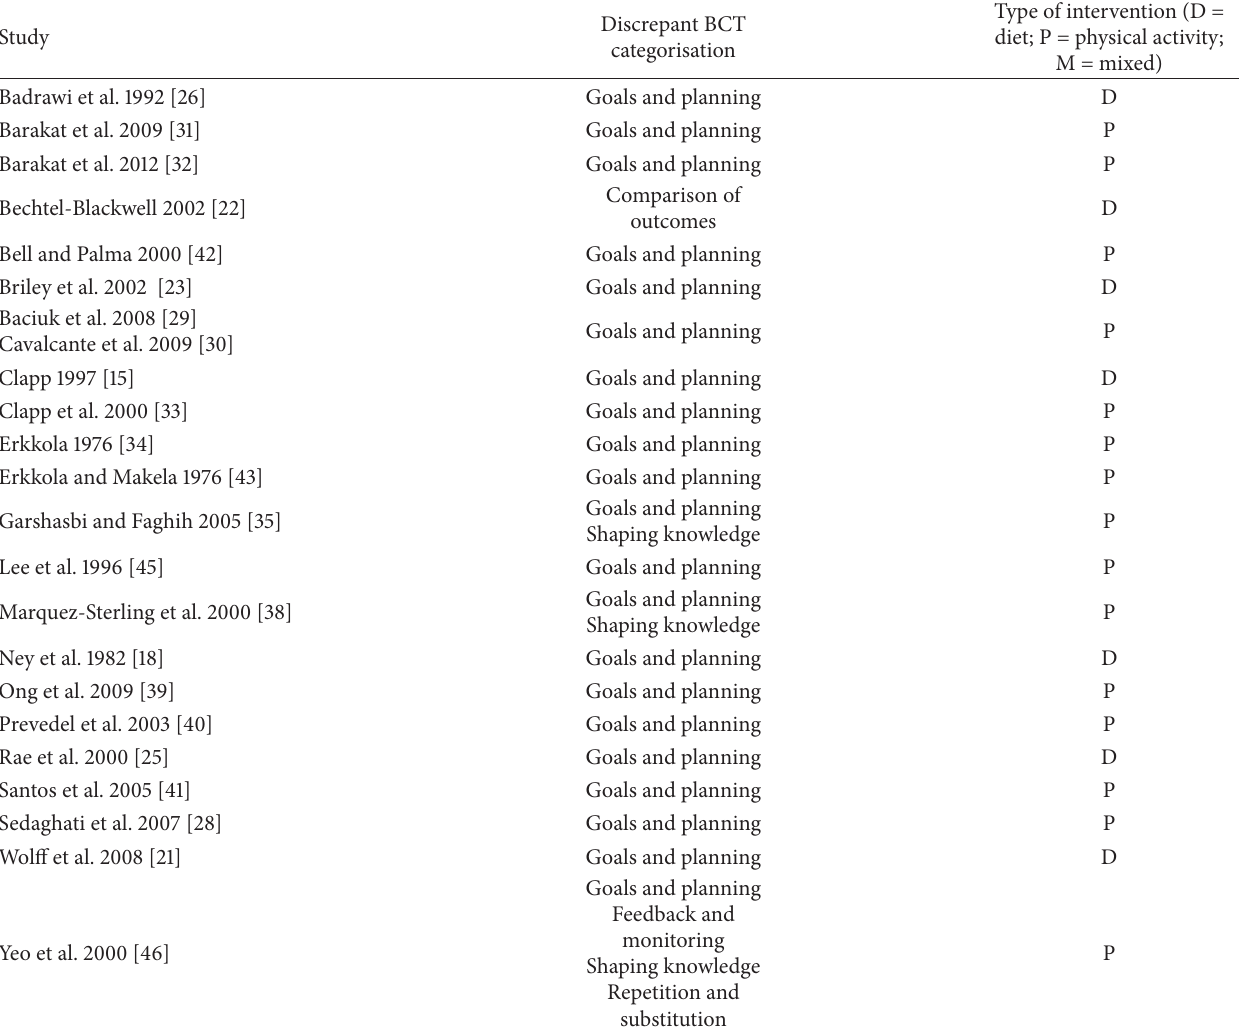
Table 2: Discrepant Behaviour Change Technique categorisation across the